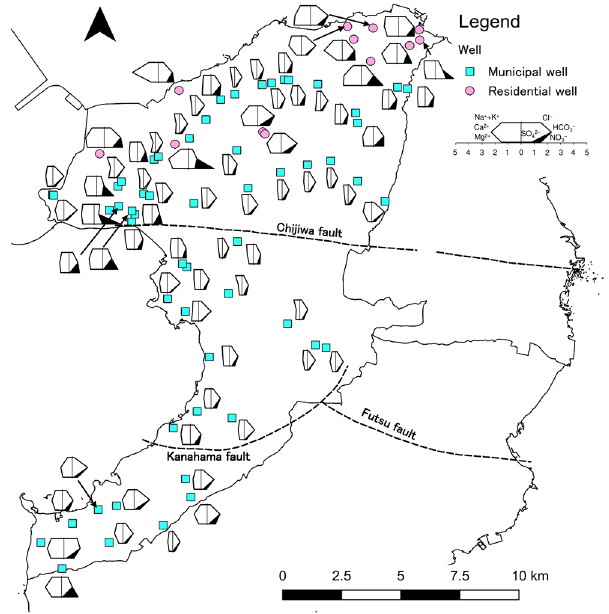
Figure 5. Major ion variation using stiff diagrams.